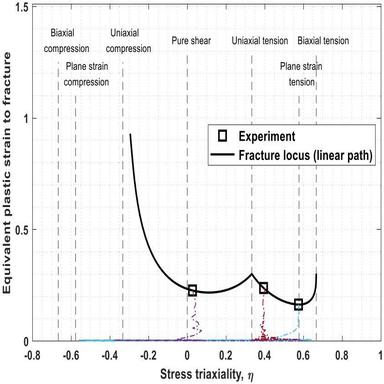
Ductile fracture test and modeling in tension and shear modes.